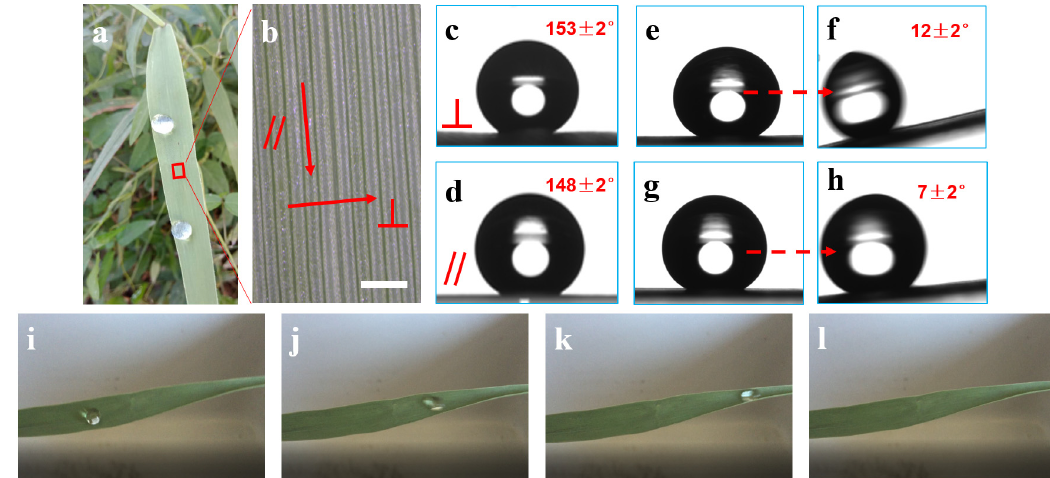
Figure 2. Photographs of wettability on the PCL surface. ( a ) A growing PCL; ( b ) a stereomicroscopic photograph of a leaf, where the bar in the figure represents 1 mm; ( c , d ) the water contact angles (WCAs) along the perpendicular and parallel vein directions; ( e , f ) the water sliding angle (WSA) along the perpendicular vein direction; ( g , h ) the WSA along the parallel vein direction; a drop of water with a volume of 0.5 mL rolls off the PCL surface after the slightest vibration ( i ) 0 s; ( j ) 0.5 s; ( k ) 1 s; ( l ) 2 s.